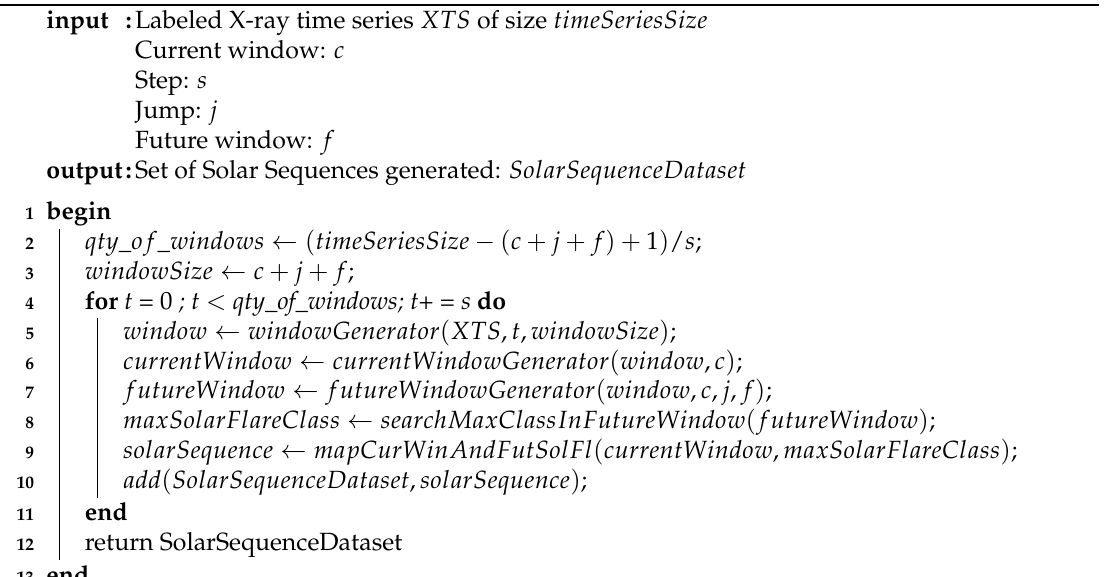
Algorithm 1: The Series to Sequence (SS)